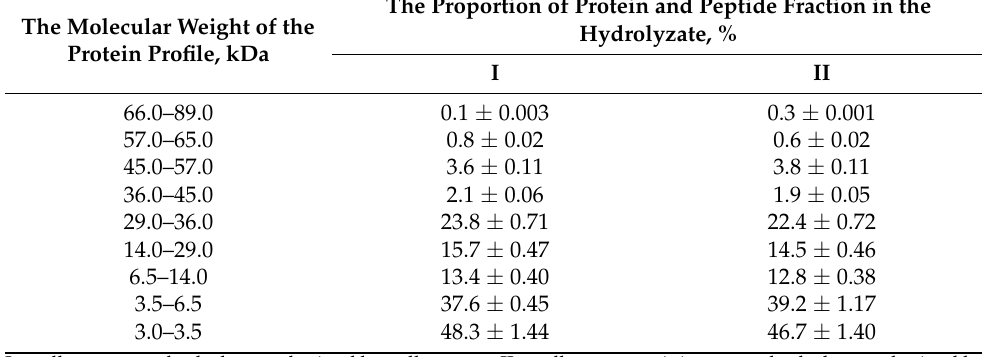
Table 2. Results of studying the peptide and protein profile of samples of collagen-containing waste hydrolysis products obtained using collagenase and Neutrase 1.5 MG. The Molecular Weight of the Protein Profile, kDa